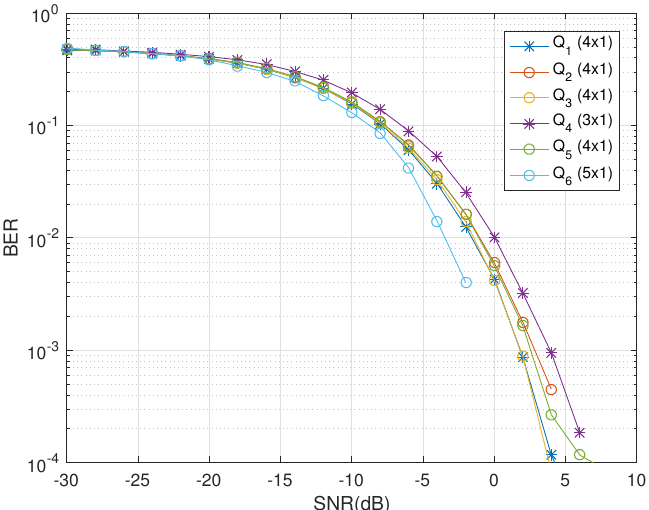
Figure 3. BER vs. SNR performance of Q 1 , Q 2 , Q 3 , Q 4 , Q 5 & Q 6 for single receive dual-polarized